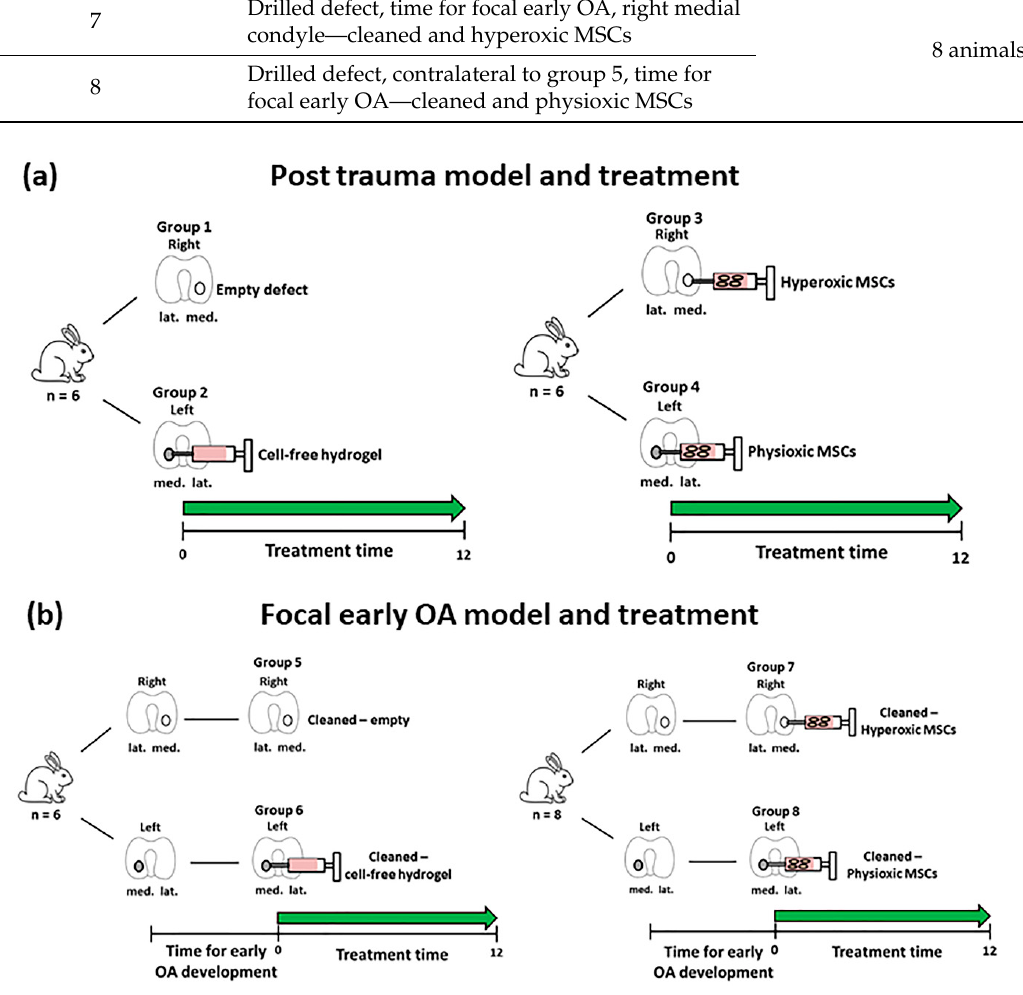
Figure 2. Schematic diagram describing the defect models of ( a ) Post-trauma and ( b ) focal early OA with the respective treatment groups for these models. Number of animals ( n ) in each group is stated in brackets.